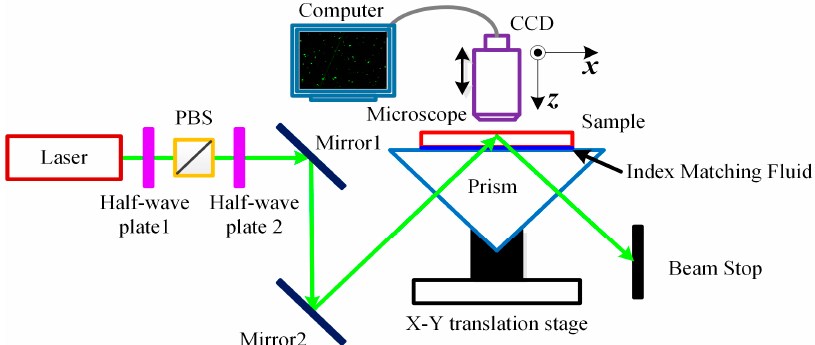
Figure 6. Schematic of the improved total internal reflection microscopy (TIRM) setup.